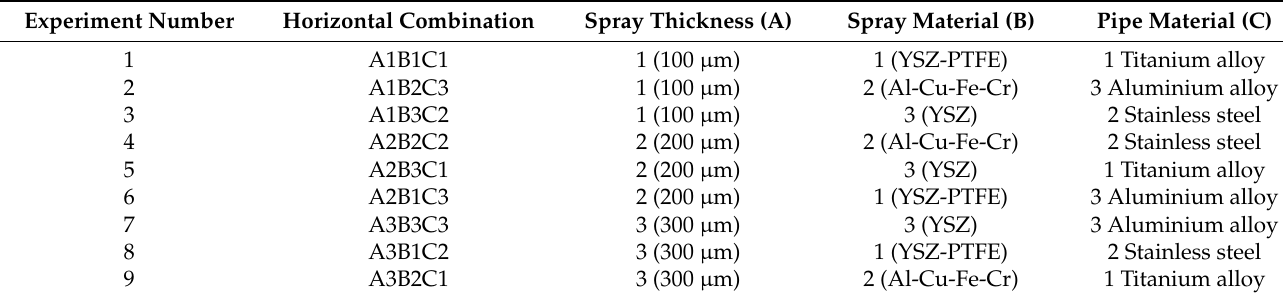
Table 2. Hard-coating spraying scheme